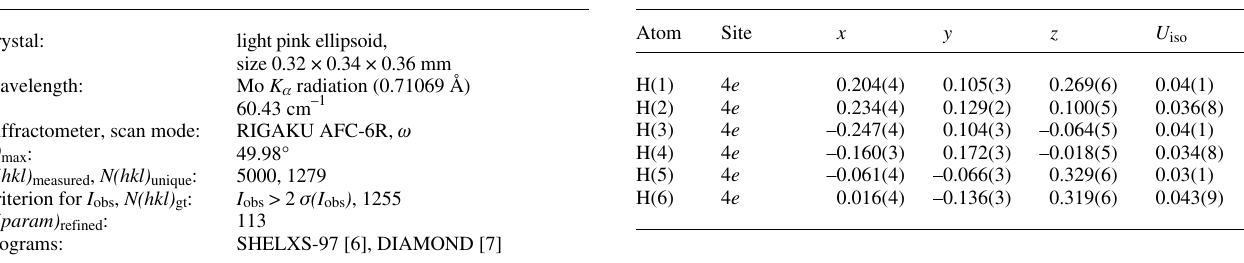
Table 4. Data collection and handling. Table 5. Atomic coordinates and displacement parameters (in Å 2 ) .